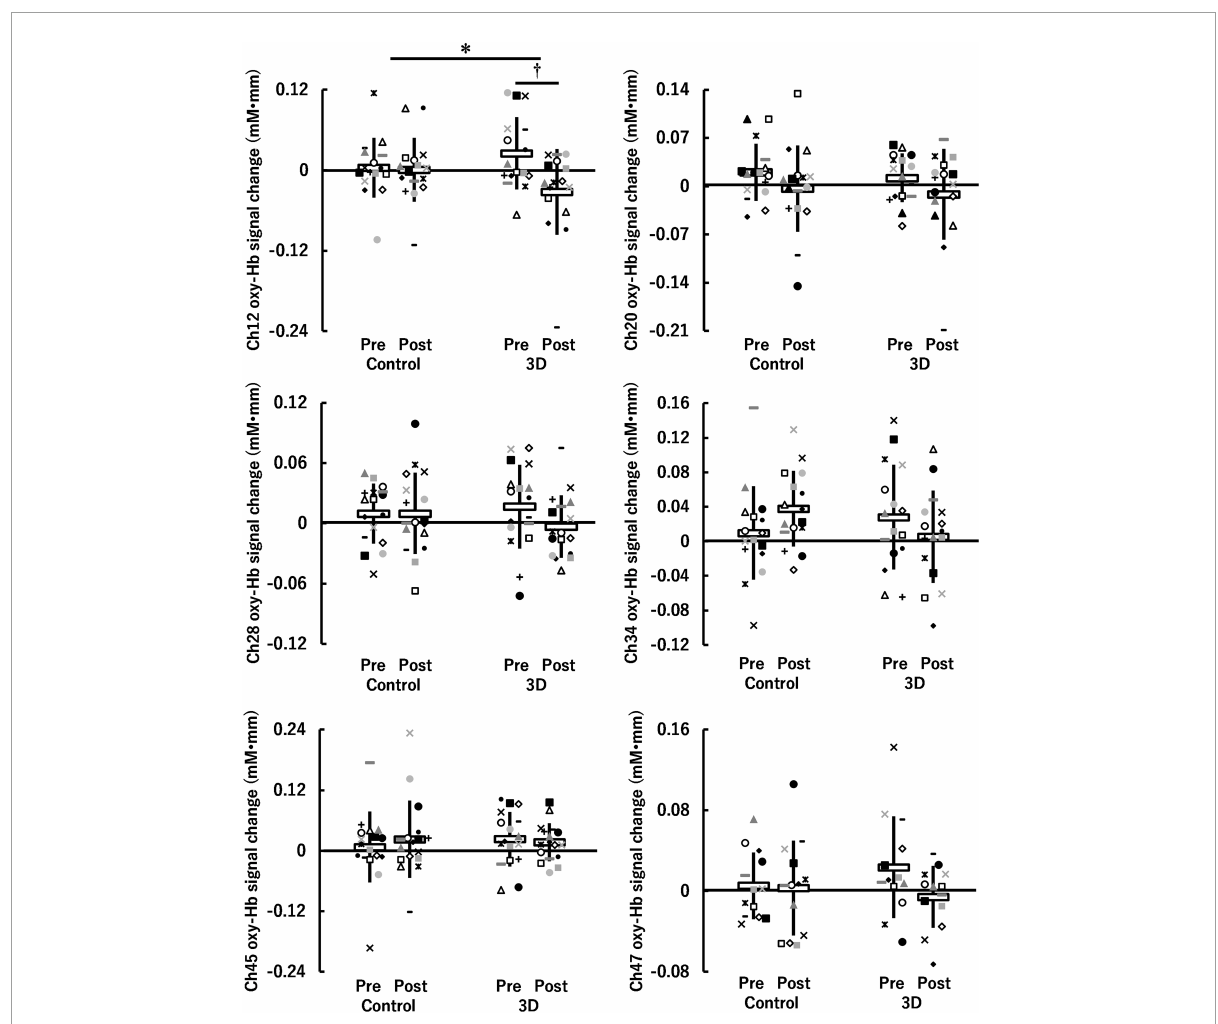
FIGURE5 Hemoglobin concentration changes (oxy-Hb signal changes) during Go/NoGo blocks in the visual task before (Pre) and after (Post) watching a 1-h movie on television in 2D (Control) and 3D. ∗ Indicates a significant time (Pre, Post) × condition (Control, 3D) interaction ( P < 0.05). † Indicates a significant difference between Pre and Post in the same condition ( P < 0.05). White horizontal bars and thick solid lines in the vertical direction indicate means ± standard deviation, respectively. Each symbol indicates individual data (ch12: n = 16, ch20: n = 16, ch28: n = 17, ch34: n = 16, ch45: n = 17, ch47: n =